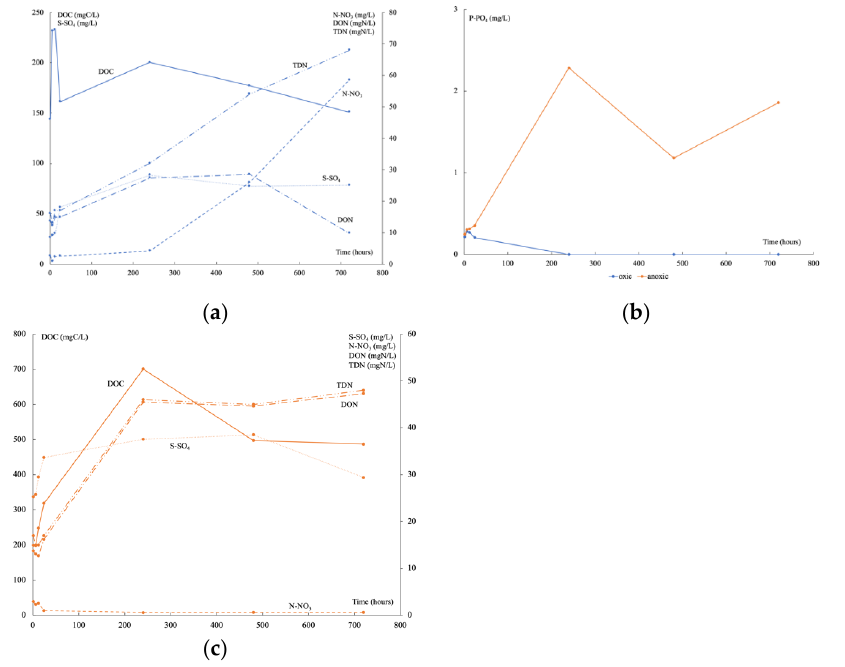
Figure 3. Time variation of DOC, S-SO 4 , N-NO 3 , DON, and TDN in oxic ( a ) and anoxic conditions ( c ), and of P-PO 4 ( b ) in oxic (blue) and anoxic (orange)